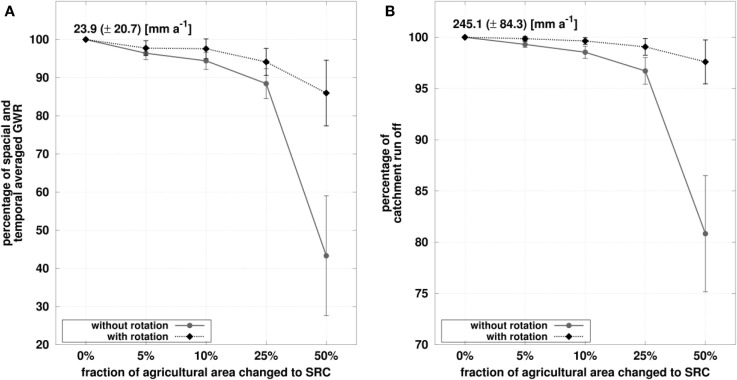
Change of ground water recharge (GWR, spatial mean over catchment area) and catchment run off relative to reference simulation (0% SRC). Mean values and SDs of relative changes are calculated over all simulated years, e.g., 30 for the simulations without rotation and 5 × 30 for the simulations with rotation. (A) Percentage of spatial and temporal averages ground water recharge (GWR). (B) Percentage of catchment runoff.